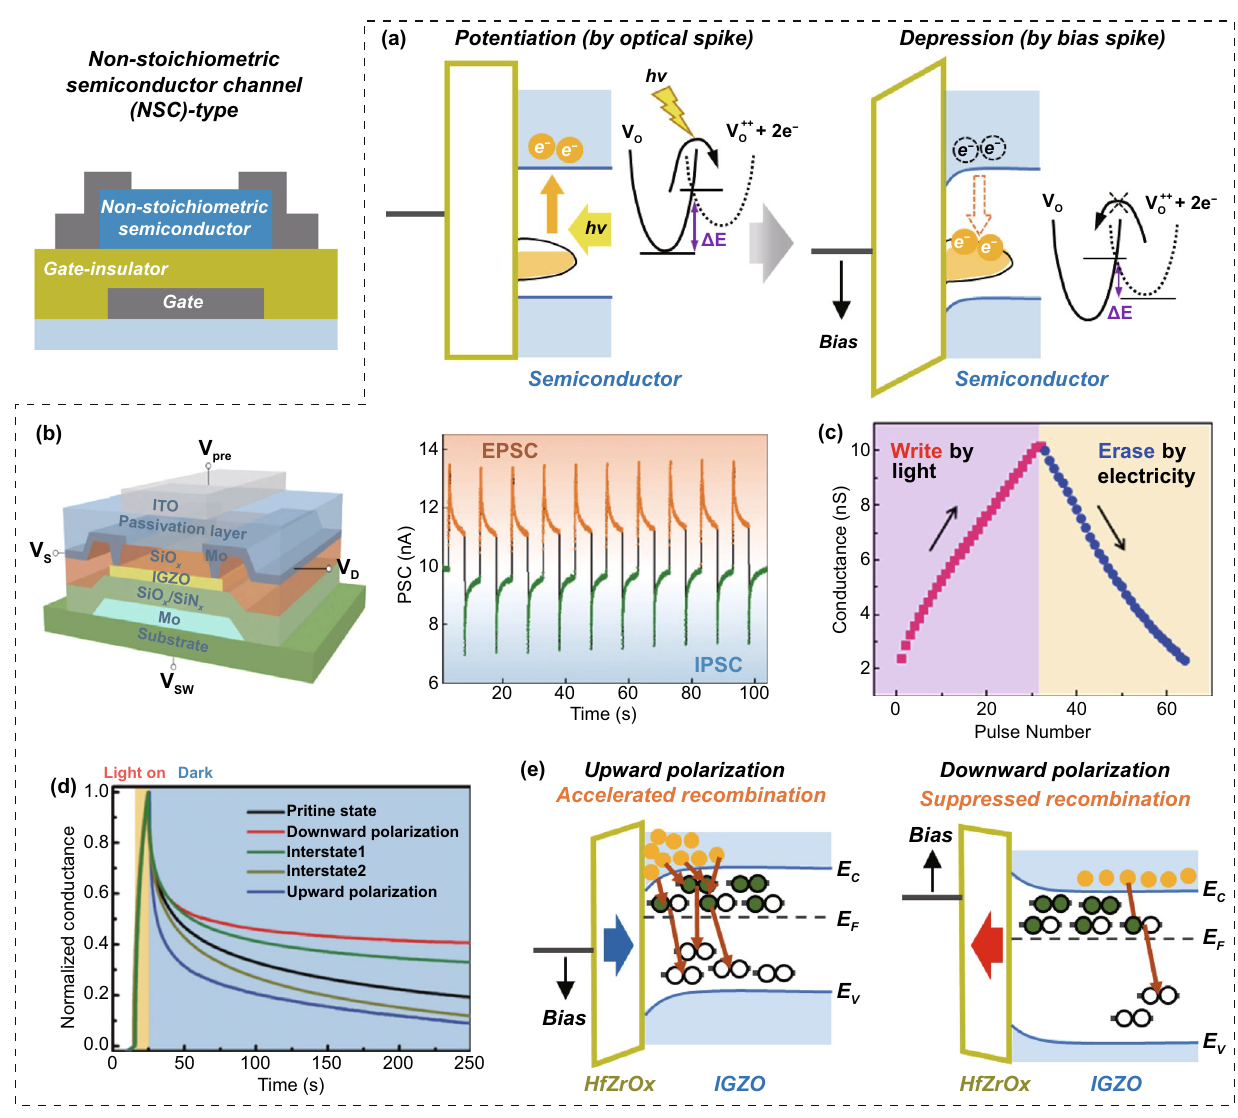
Fig. 10 Non‑stoichiometric semiconductor channel (NSC) transistor‑type OS; a operational mechanism. AOS‑NSC transistor‑type ES using charge trapping structure of SiO 2 /SiN x at gate dielectric; b optical potentiation and electrical depression characteristics and c linear conductance update behavior. AOS‑NSC transistor‑type ES using ferroelectric HfZrO x at gate dielectric; d retention engineering of optically programmed conductance state and e operation mechanism depending on polarization direction of ferroelectric HfZrO x . b , c Reproduced with